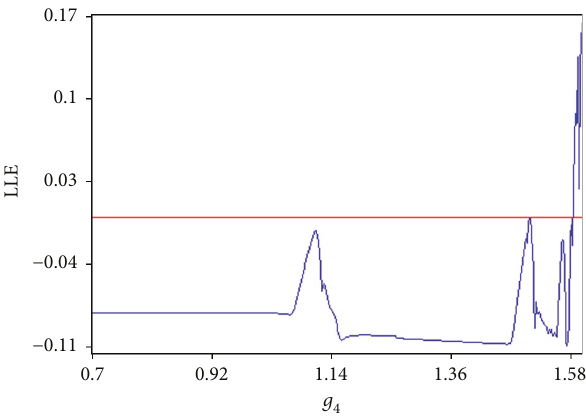
Figure 13: The largest Lyapunov exponent of the system with ∈ 0 7, 1 , k 2 , w 1 , w 2 when g 3 respect to g 4 ∈ 0 7, 1 73 .